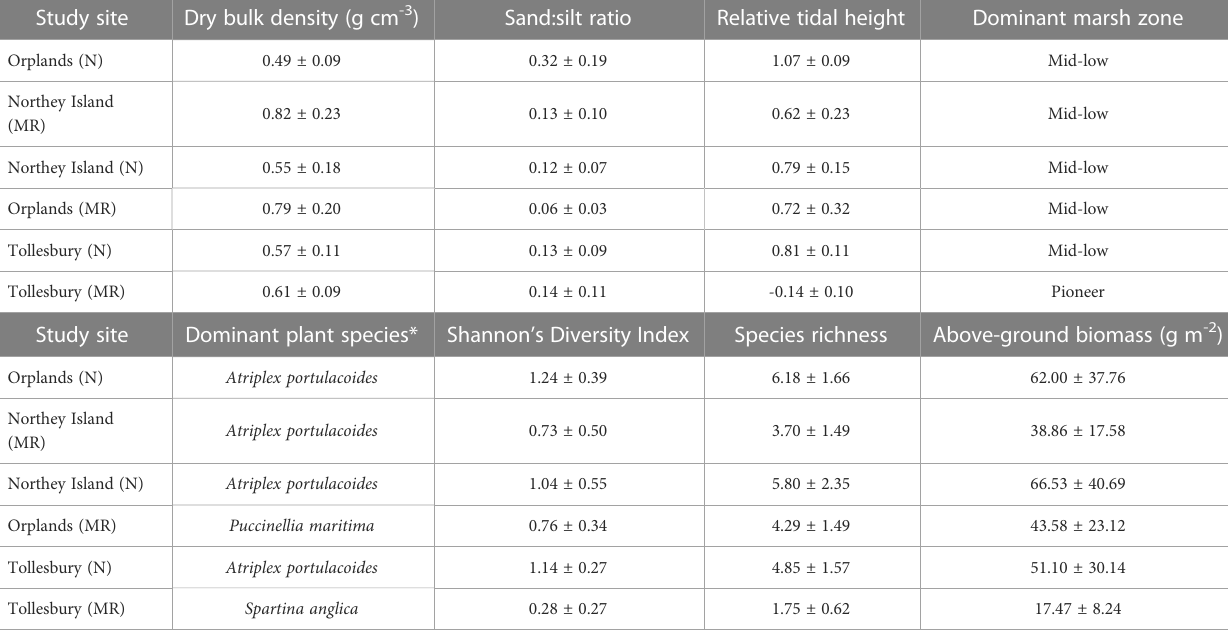
TABLE 3 Mean environmental variables at each natural (N) and managed realignment (MR) site ± standard